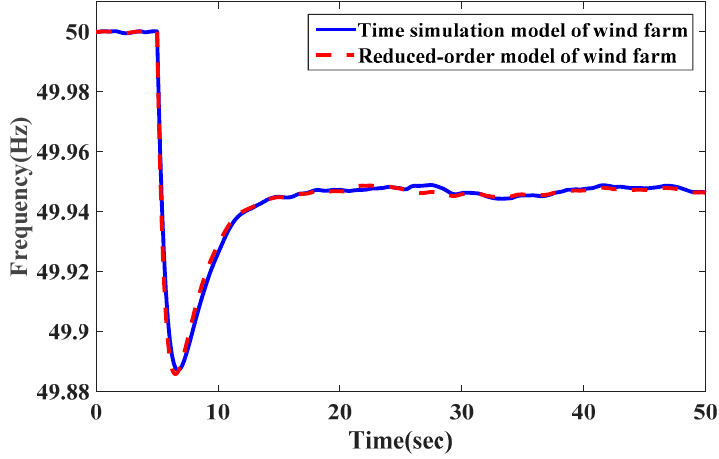
Figure 9. Comparison of reduced-order model with time simulation model of wind farm.